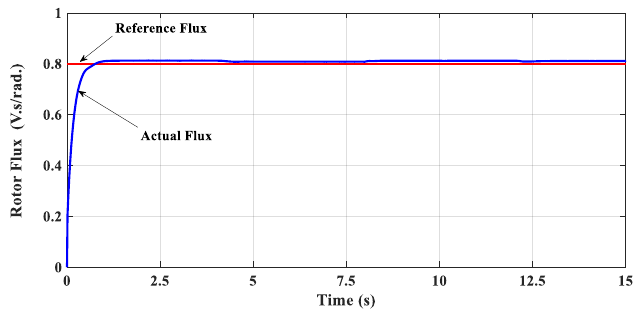
Figure 19. Response of the rotor flux under parameter changes (150% uncertainty).